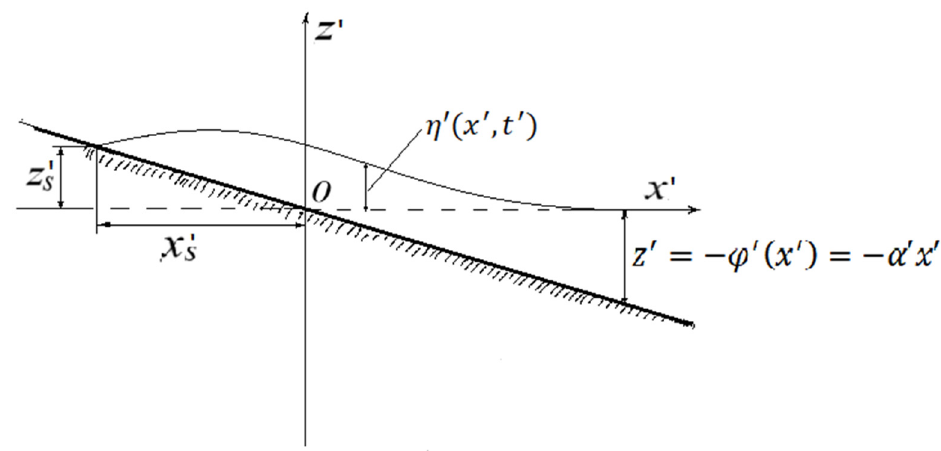
Figure 1. A schematic of the seafloor setup which was used in papers [3,4,11].